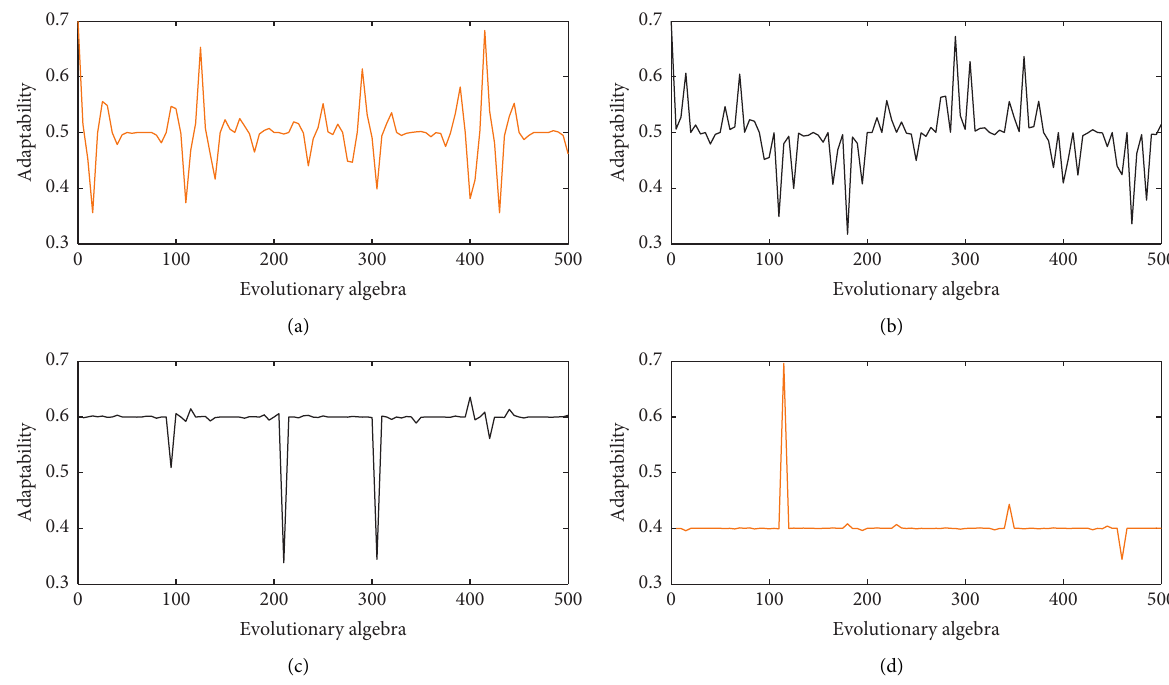
Figure 4: Fitness curve of single parameter extraction. (a) The fitness of zero-frequency resistivity extraction. (b) The fitness of charging rate extraction. (c) The fitness of time constant extraction. (d) The fitness of frequency correlation coefficient extraction.